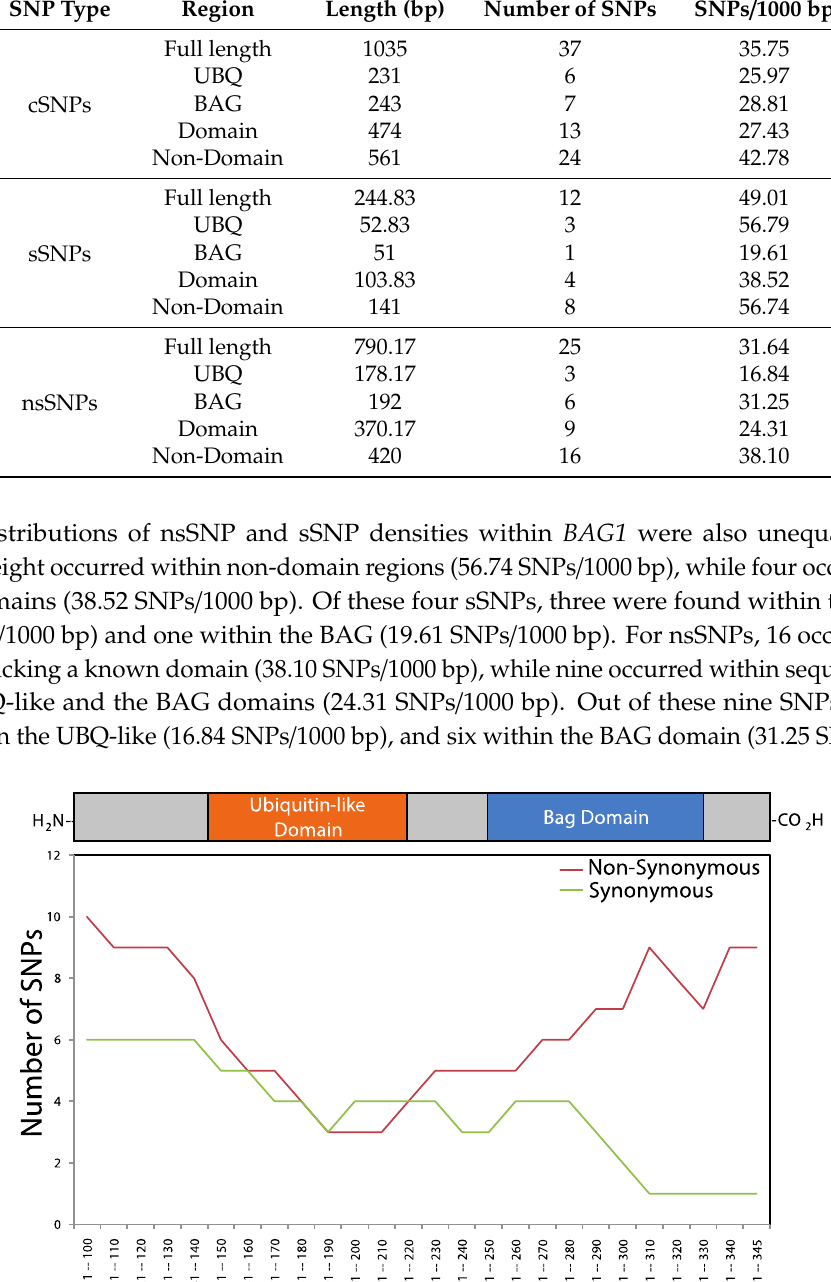
Table 4. Ratios of proportions of nsSNPs and sSNPs within BAG1.